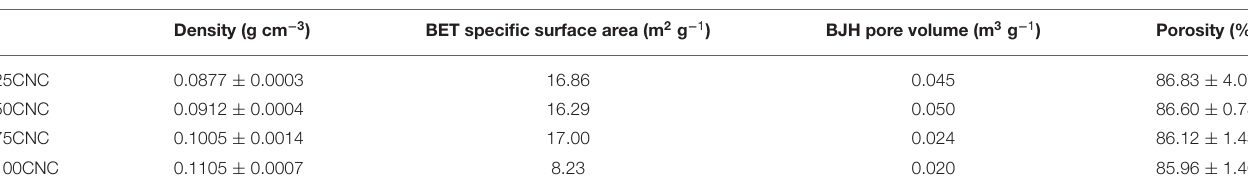
TABLE 2 | Physical parameters of CNC